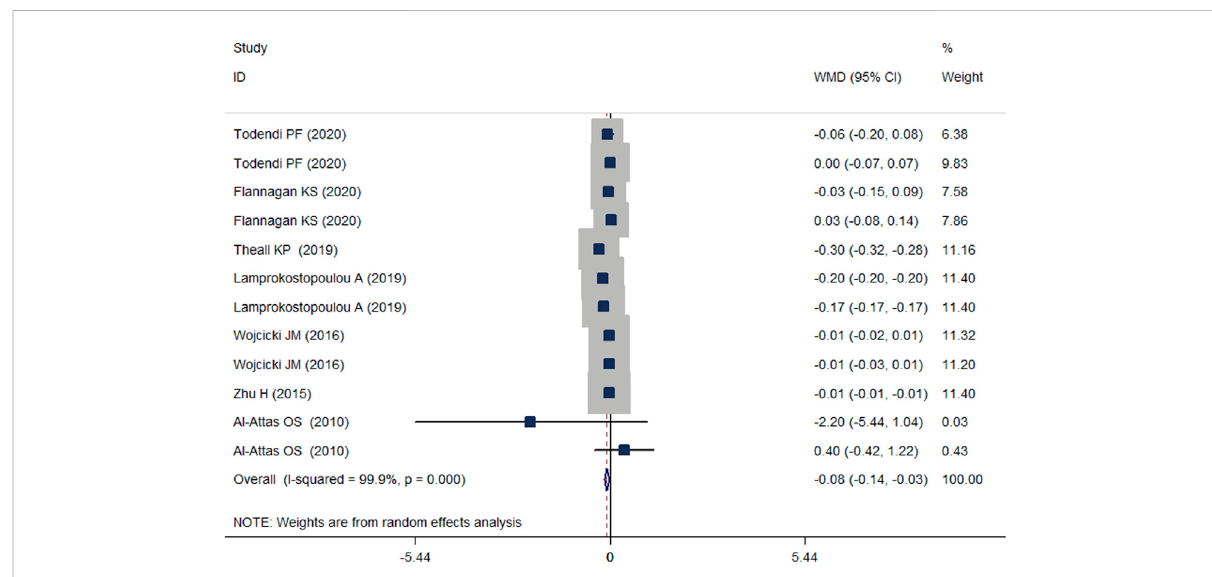
FIGURE 2 Weighted mean difference (WMD) with a 95% con fi dence interval (CI) of the comparison of leukocyte telomere length (LTL) in children and adolescents with or without